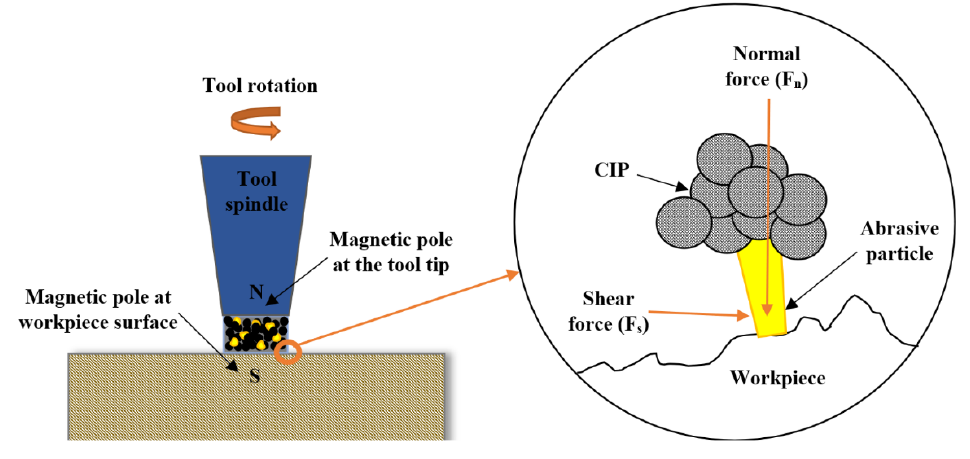
by using ball end magnetorheological finishing (BEMRF). In this process, the MR fluid is